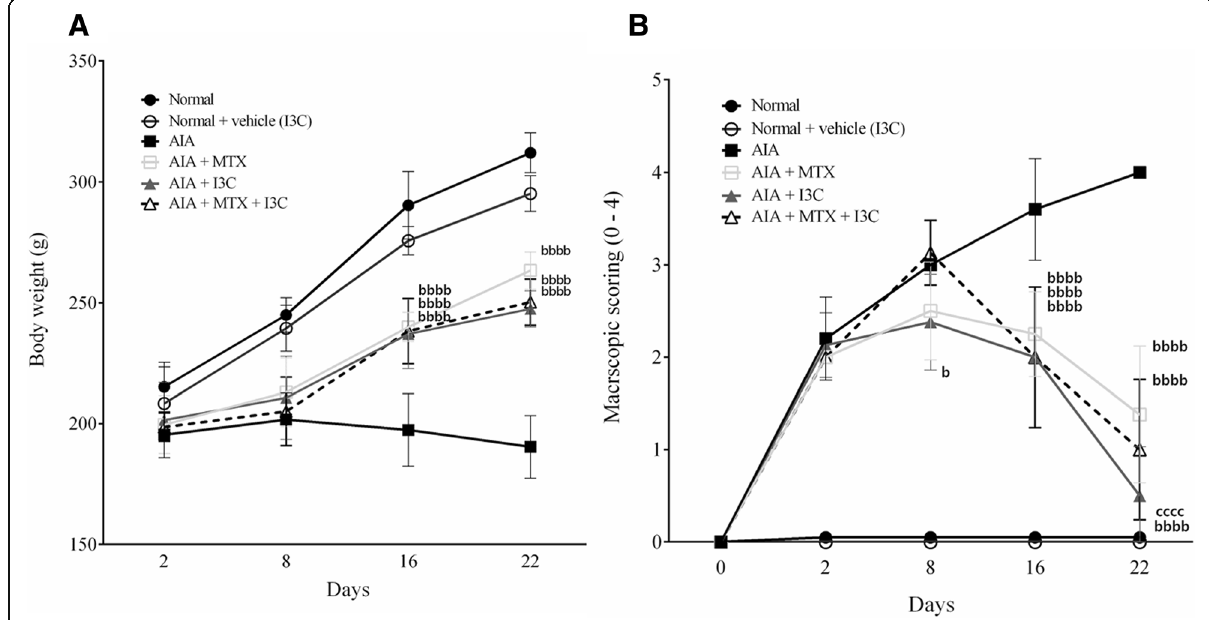
Fig. 2 Assessing the effect of I3C by clinical evaluation. a Mean change in body weight of rats monitored once per week ( n =8). b Mean change in macroscopic score (0 – 4) of rats monitored once per week ( n =8). bbbb p <0.0001 compared with arthritic non-treated model group (AIA), cccc p